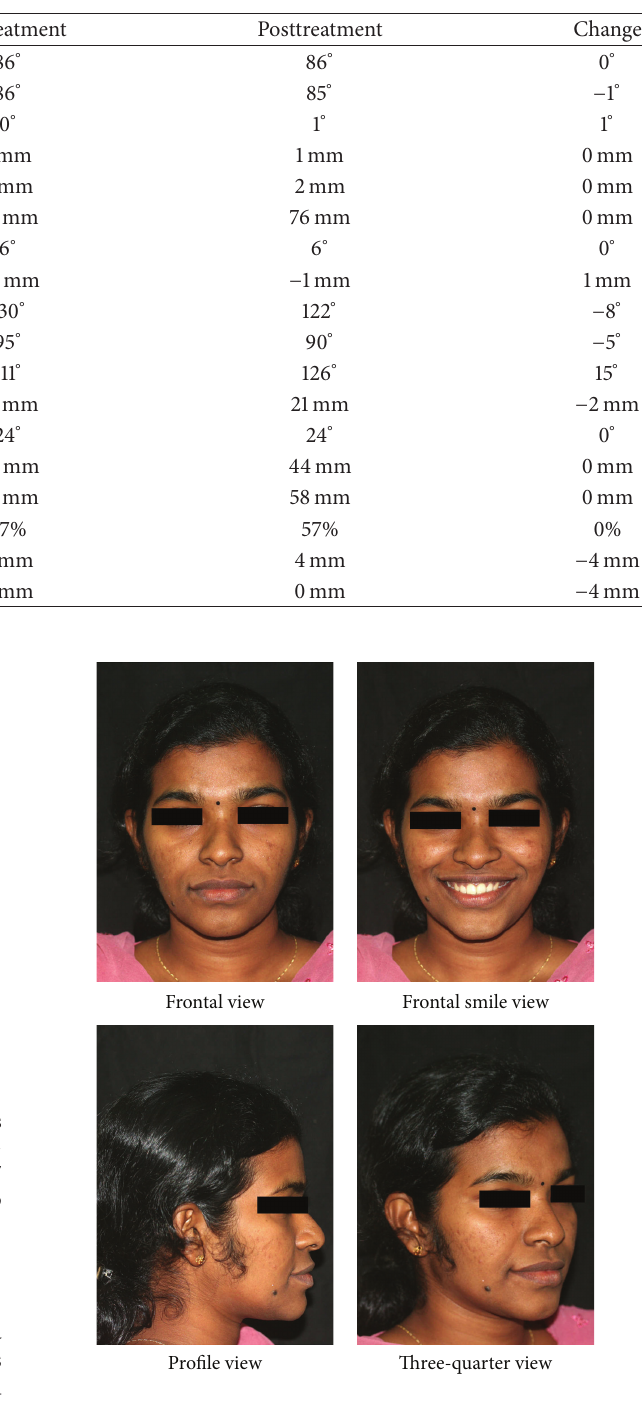
Table 1: Pre- and posttreatment cephalometric values.